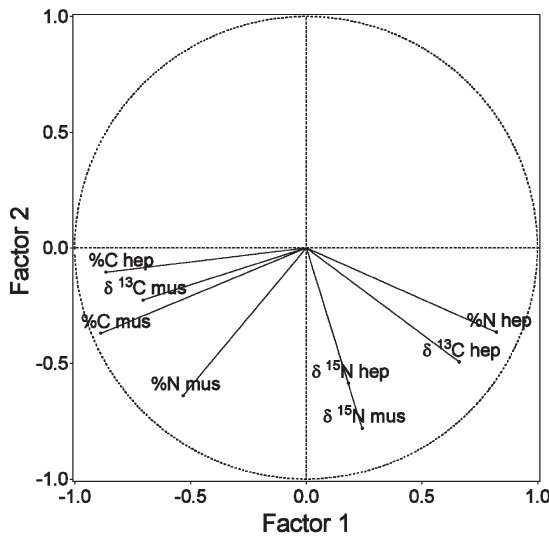
Fig . 4. – Correlation of elemental composition (shown as C and n percentages) and isotope ratios ( δ 13 C e δ 15 n) for hepatopancreas (hep) and muscle (mus) with the two main factors extracted from